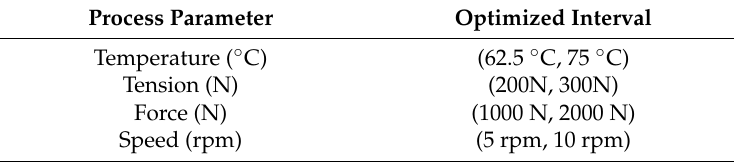
Table 5. Results of interval optimization for process parameters of the tensile strength model.